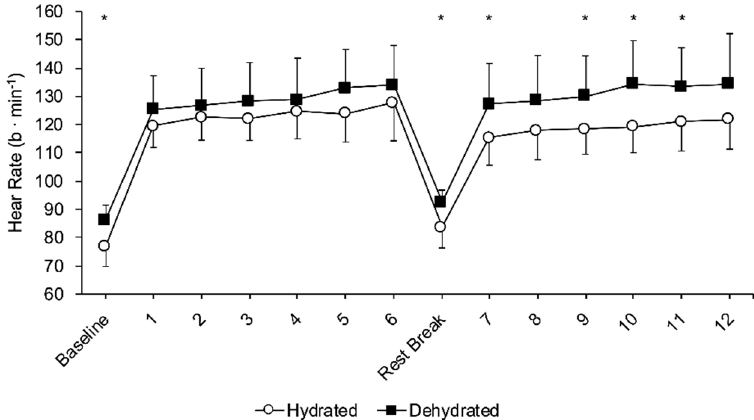
Figure 4. Heart rate response to hydration (open circles) and dehydration (dark squares) state, during the archery competition simulation. * Indicates difference between trials ( p < 0.050). During exercise, heart rate was higher than baseline in both trials.